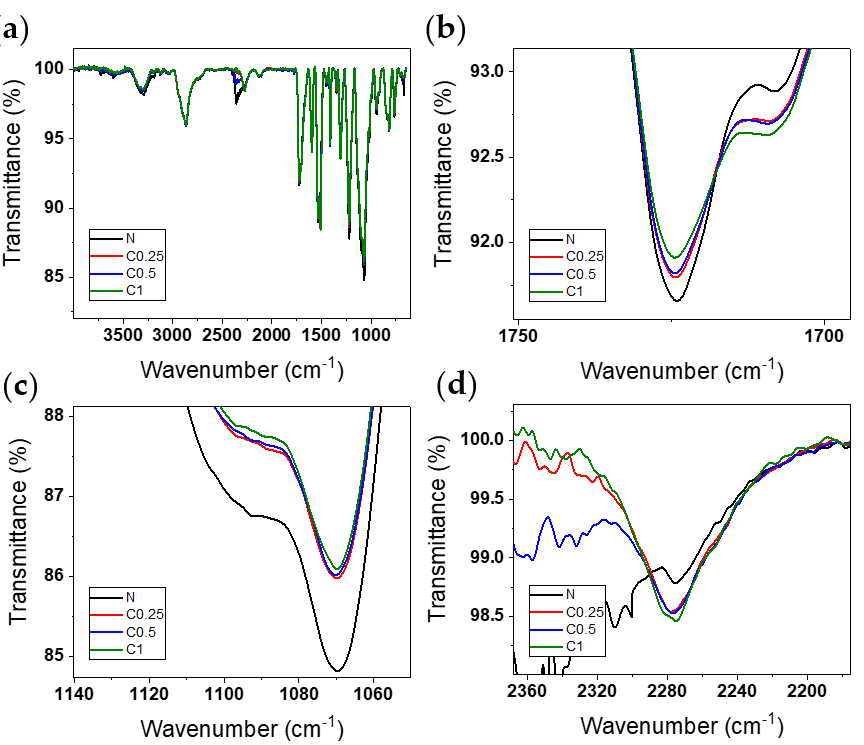
Figure 4. FTIR spectra of PU foams, ( a ) expanded view of the spectra, ( b ) carbonyl peaks of urethane group at 1724 cm −1 and 1707 cm −1 , ( c ) C-O-C peak of urethane group at 1069 cm −1 , and ( d ) isocyanate peak of pMDI at 2270 cm −1 .